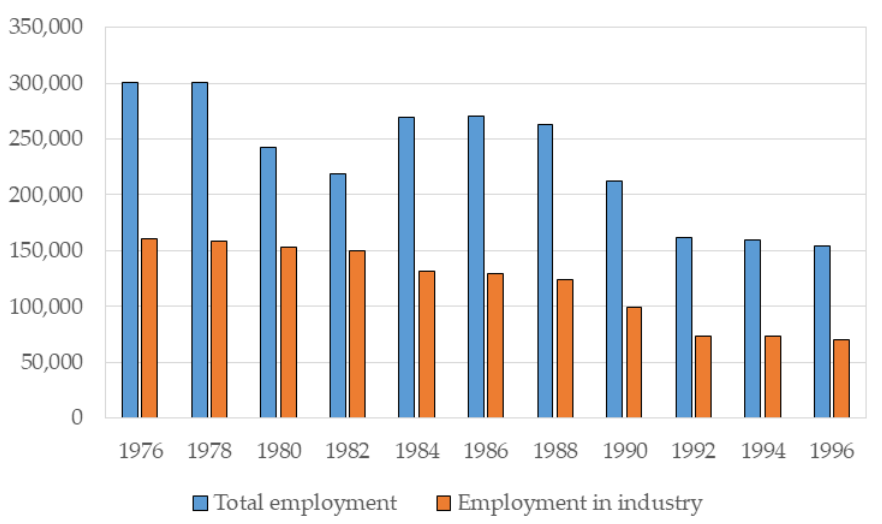
Figure 2. Employment in the Wałbrzych Voivodeship in the years between 1976 and 1996 (own study based on [16]).